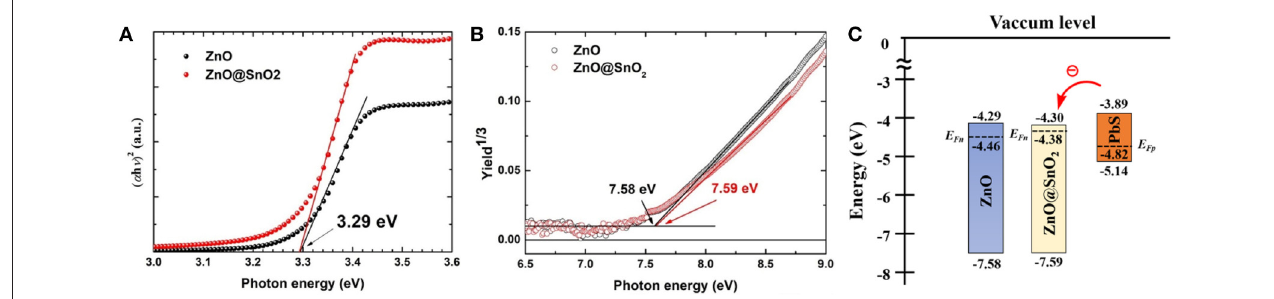
FIGURE 4 | (A) Tauc plots obtained from the absorption spectra of ZnO NWs and ZnO@SnO 2 NWs. (B) PYS spectra of ZnO NWs and ZnO@SnO 2 NWs. (C) Schematic energy band diagrams of ZnO NWs, ZnO@SnO 2 NWs, and PbS CQDs.